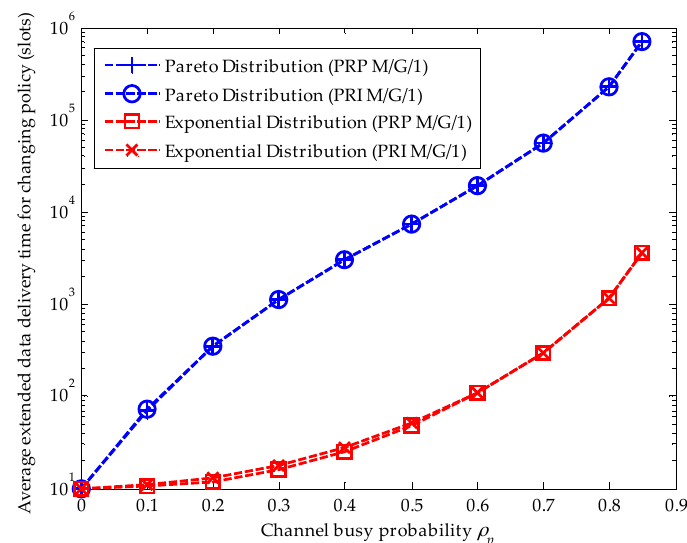
Figure 5. Effects of the upper-truncated Pareto distribution and the exponential distribution for primary connections when the changing policy is adopted in the preemptive repeat identical (PRI) M/G/1 and the preemptive resume priority (PRP) M/G/1 queuing network models, where λ s “ 0.01 (arrivals/slot), E r X s s “ 10 (slots/arrival), t s “ 1 and